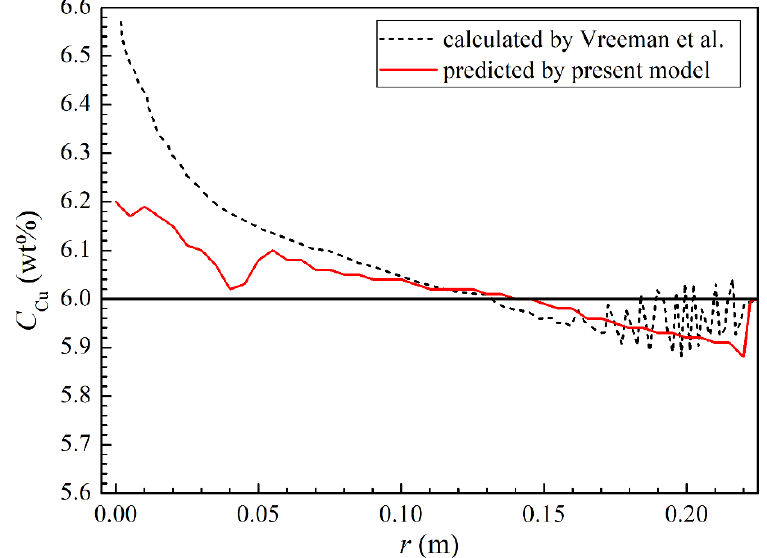
Figure 7. Radial Cu composition profiles predicted by present model at the height of 500 mm and calculated by Vreeman et al. [21] at steady state in the non-grain-refined billet (case 2).